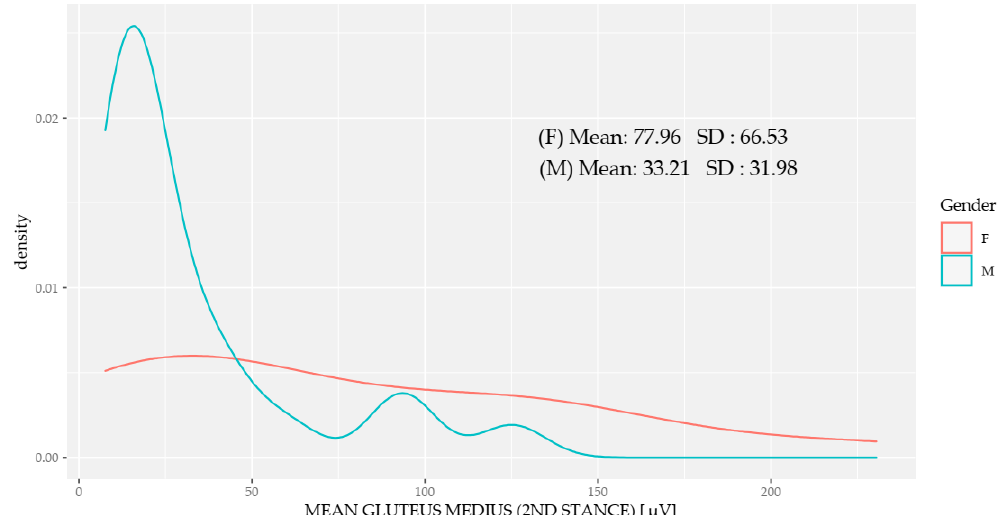
Figure 5. Variation between the sexes in the mean gluteus medius activation during the second